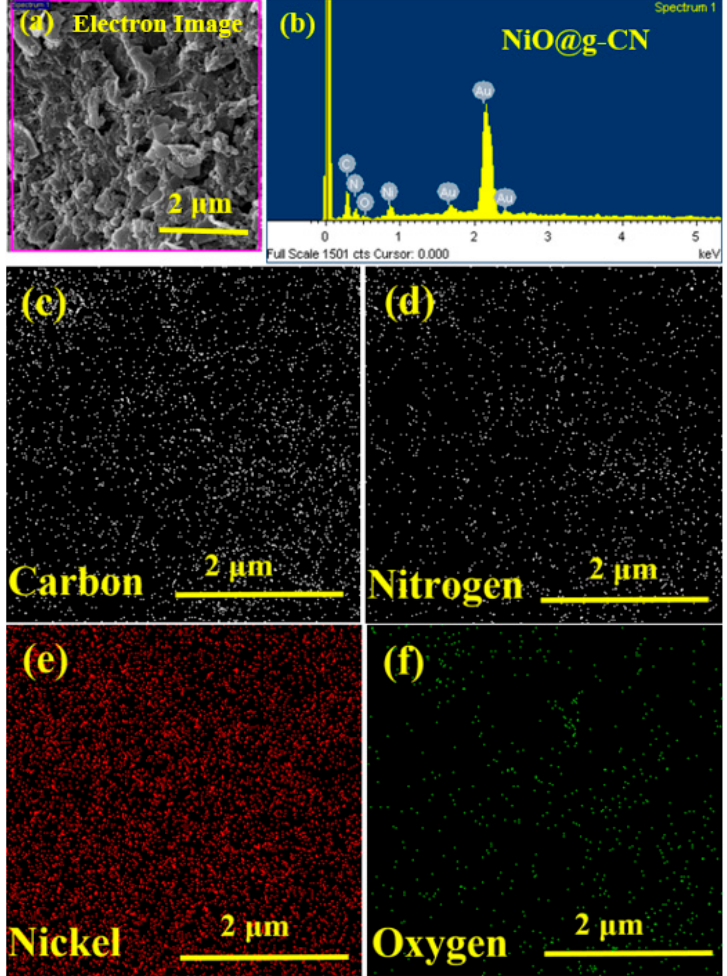
Figure 4. Elemental analysis of the NiO@g-CN nanocomposite. ( a ) Low-magnification FE-SEM image of the NiO@g-CN nanocomposite, showing the selected area for EDX and elemental mapping analysis. ( b ) EDX spectrum of NiO@g-CN nanocomposite. Elemental maps for carbon ( c ), nitrogen ( d ), nickel ( e ), and oxygen ( f ).